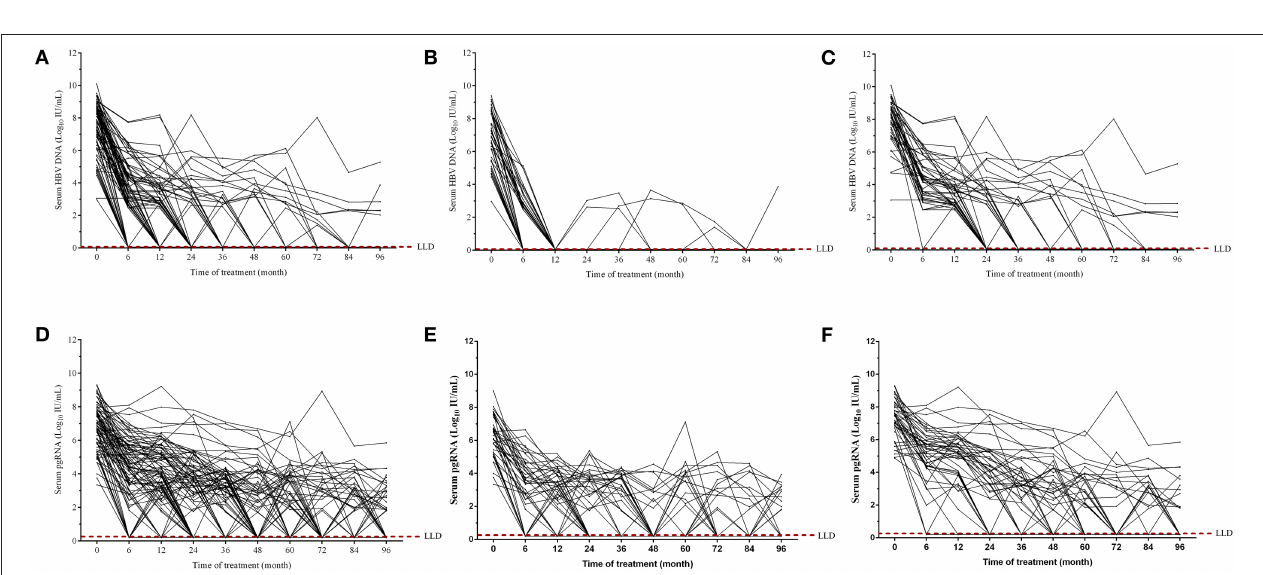
FIGURE 4 | Dynamics of serum HBV DNA (A–C) and pgRNA (D–F) during the 96-month NAs treatment. Dynamic changes of serum HBV DNA and pgRNA levels from baseline to month 96 in all patients (A,D) , in patients treated with ETV (B,E) , and in patients treated with LAM/ADV/LdT treatment (C,F) .